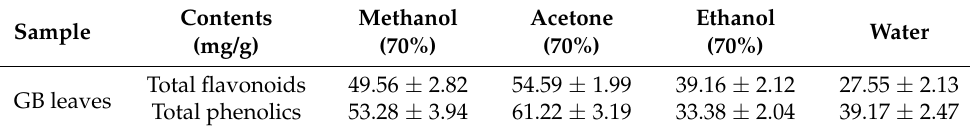
Table 1. Total contents of flavonoids and phenolics (mg/g dry weight) of GB leaves.